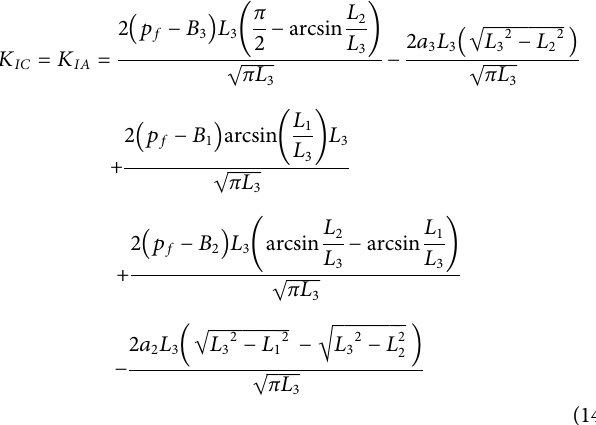
FIGURE 6 The σ y distribution along the WIF with different damage variables( D